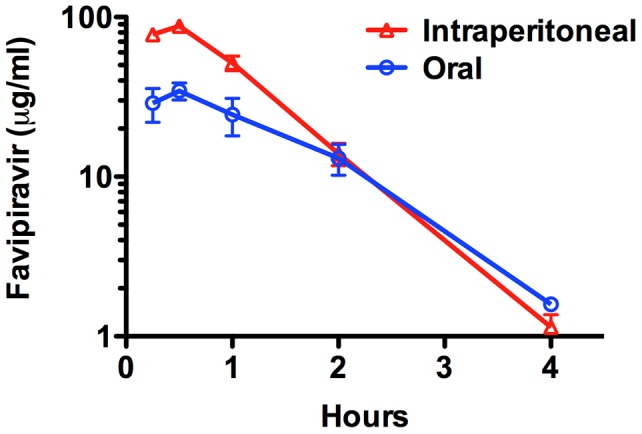
PK analysis of favipiravir in male Hartley guinea pigs dosed by oral instillation or intraperitoneal (i.p.) injection.Favipiravir (100 mg/kg) was administered orally in carrot baby food vehicle or by i.p. injection in 2.9% sodium bicarbonate. Longitudinal plasma favipiravir levels are shown from 3 animals per treatment group at 15 and 30 minutes, and 1, 2, and 4 h after treatment. Data points represent the mean and standard error of the mean.